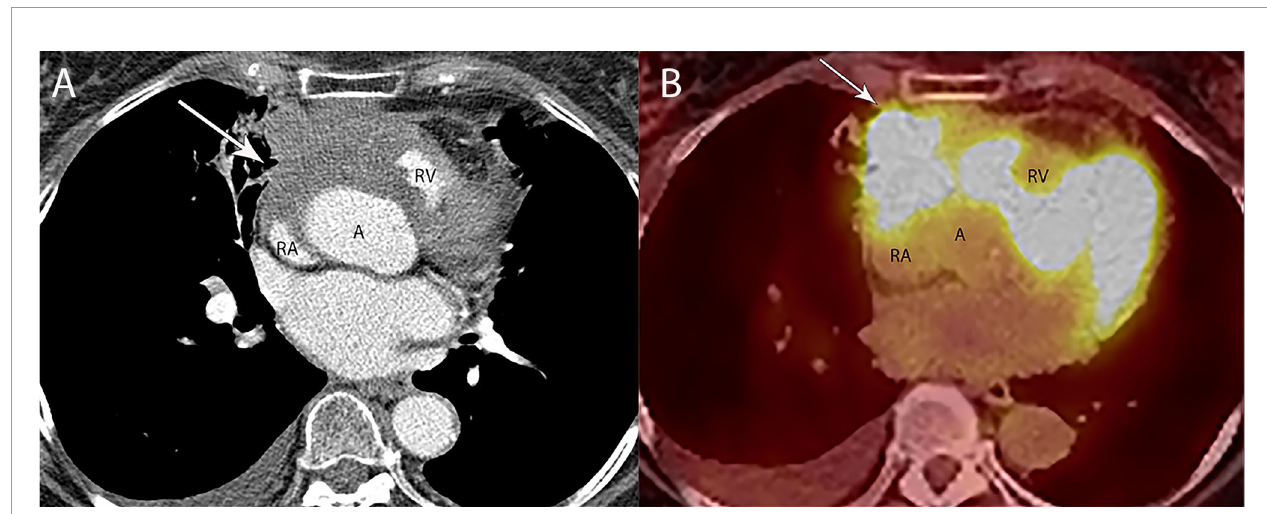
FIGURE 2 | 80 year old woman with adenosquamous thymic carcinoma. (A) Contrast-enhanced CT shows right prevascular mediastinal tumor (arrow) invading the pericardium between the right atrium (RA), ascending aorta (A) and right ventricle (RV). (B) PET/CT shows the tumor is markedly FDG avid.